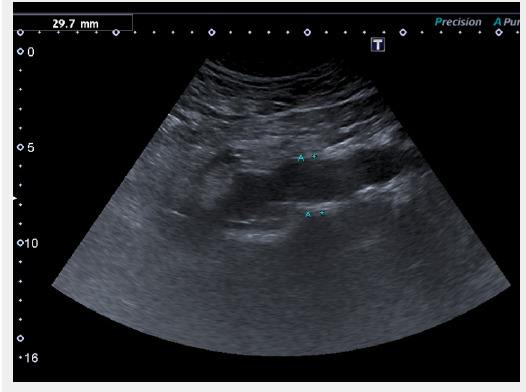
Previously undiagnosed small abdominal aortic aneurysm detected on vascular duplex ultrasound in a 62-year-old smoker with erectile dysfunction, otherwise asymptomatic regarding cardiovascular